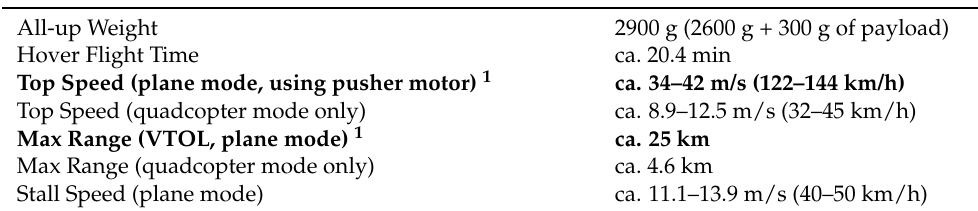
Table 2. Predicted performance of the electric drive setup; assumed 90% max allowed discharge